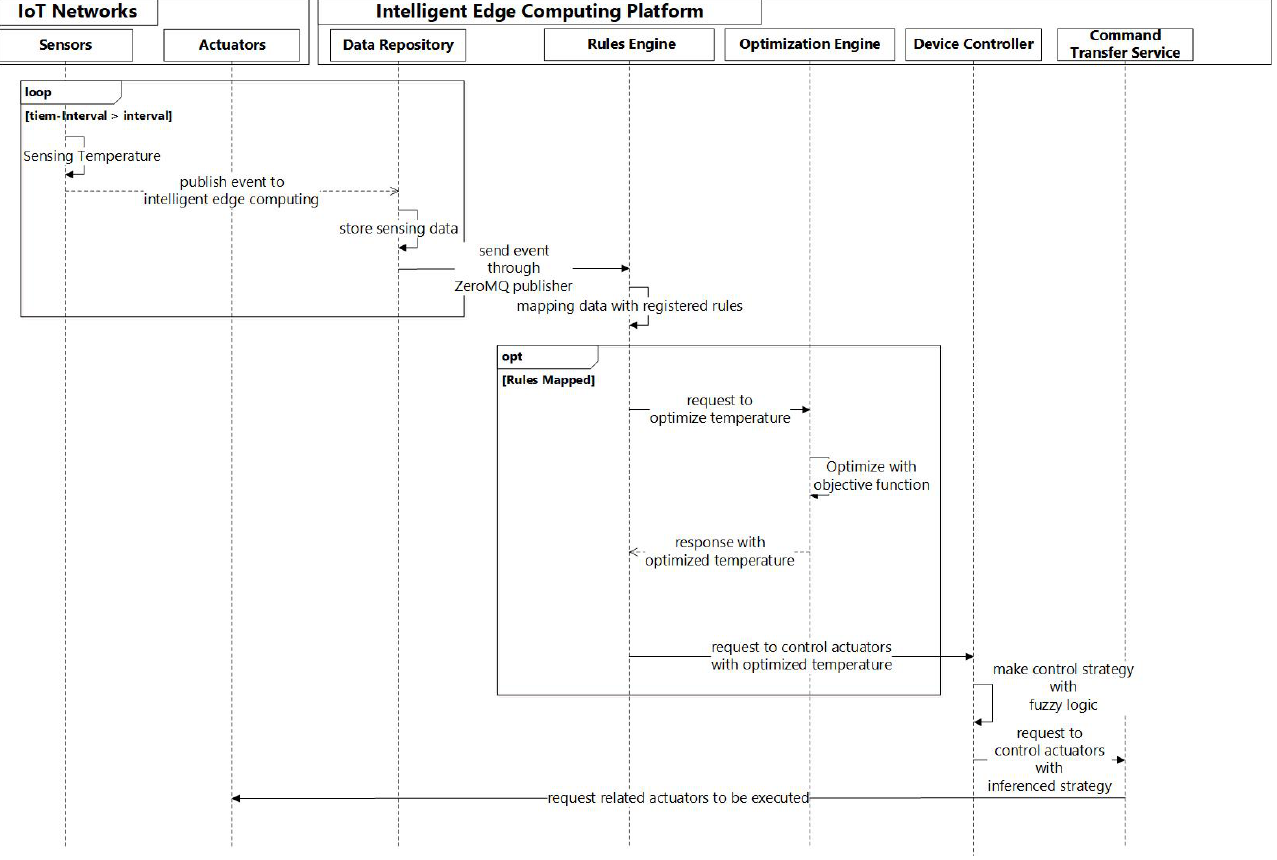
Figure 6. Optimization Mechanism-based Sequence Diagram for Home Appliances